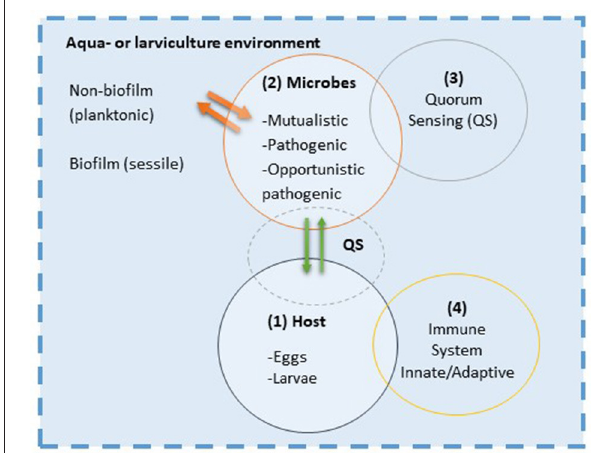
FIGURE 9 | Host-microbe interaction concept model: In the aquaculture environment interaction between host (1) and microbes (2) basically start with a physical contact where bacteria attach to the surfaces of the host; the skin mucus, gills or gastrointestinal tract. Establishment of surface contact by microbes is through mechanisms such as chemotaxis and the use of fimbriae or pili (host cues might be utilized by microbe for that). Microbes communicate through chemical signaling, e.g., quorum sensing (QS; 3). This cell-to-cell signaling allows microbes to monitor the environment, and they alter cell population and/or activity in response to the chemical signal. There is also a cross-talk between quorum sensing and secondary messenger nucleotides, which are important for the fitness of the microbes by allowing switching between phenotypes in an unpredictable environment. This strategy also known as bet-hedging, is important for generating variable offspring in microbes and thus reduce the risk of being maladapted to the evolving (ontogeny) host environment. Changes from planktonic to sessile state (phase variation probably controlled by epigenetic mechanisms) in the biofilm and pili formation are example of bet-hedging strategy of bacteria. The host might sense the presence of colonizing microbes through their MAMPs (microbe-associated molecular patterns) modulating the innate immune responses (4) of the host. This in turn might shape the microbial community composition and its in vivo activity. The innate immunity plays a pivotal role in orchestrating the immune cells to determine the outcome of the host-microbial interaction which can be on the scale from mutualistic to